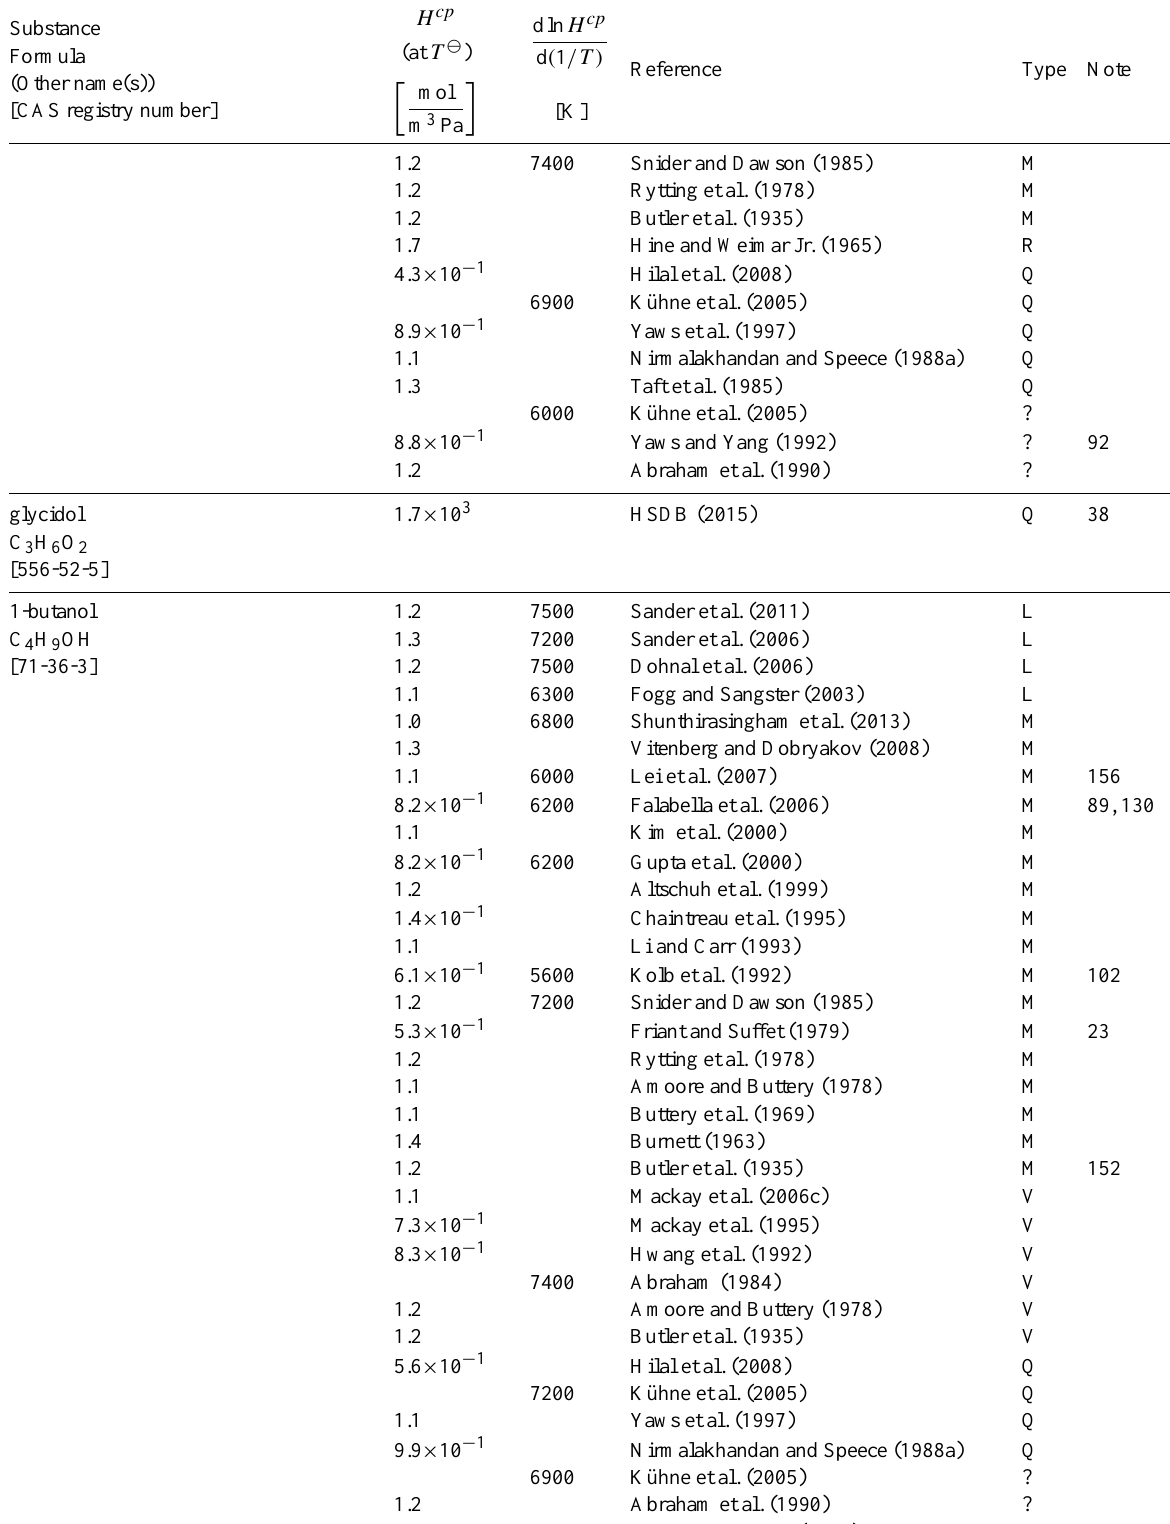
Table 6: Henry’s law constants for water as solvent